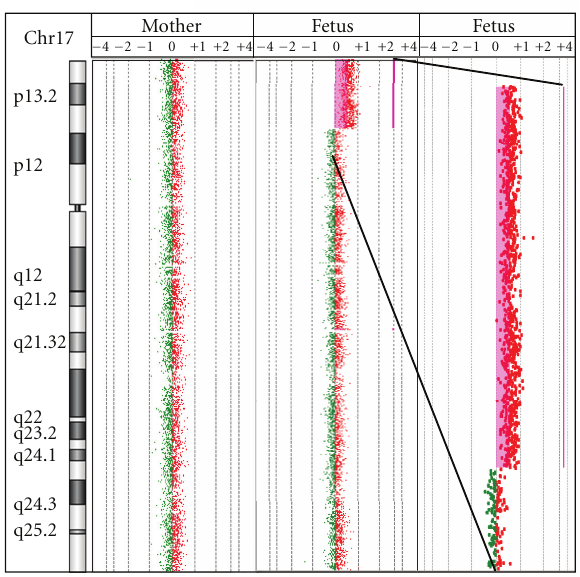
Figure 2: GMA results. The GMA results show a duplication of 17p13.1p13.3 of the fetus and a normal result of the mother.